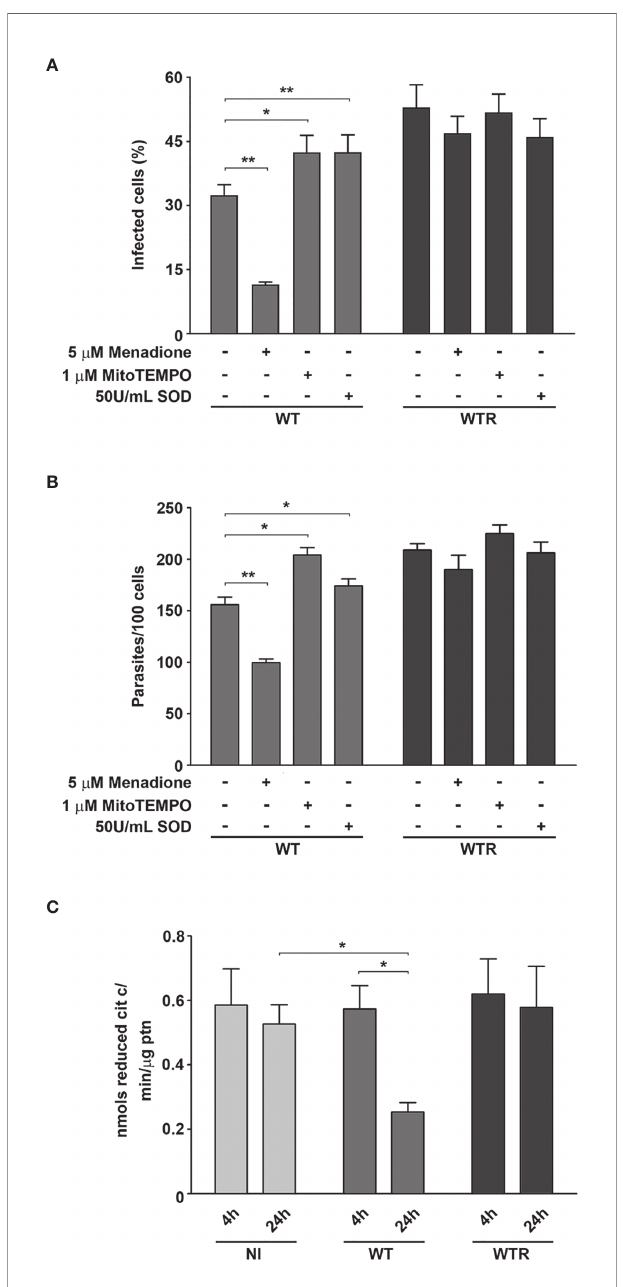
FIGURE 7 | Wild type (WT) infection led to a host mitochondrial impairment. (A) Percentage ofinfected cellsand (B) number ofadheredparasites per 100 cells at 24 h(*p= 0.02, **p= 0.01). Aag2 cells weretreatedwith5 µM menadione, 1 µM mitoTEMPO, or 50U/mlsuperoxidedismutase (SOD) for 2 hbefore the infection. After that, the infectionwithWT andhydrogenperoxide(H 2 O 2 )-resistant (WTR) strainswas performedas describedabove. (C) MitochondrialcomplexI – III activity ofnon-infected(NI) and WT- andWTR-infectedculturesat 4and24h (*p= 0.02). Signi fi cant p-values were obtainedbyMann – Whitneytest, anderror bars represent themean ±SDof at least three independentexperiments.